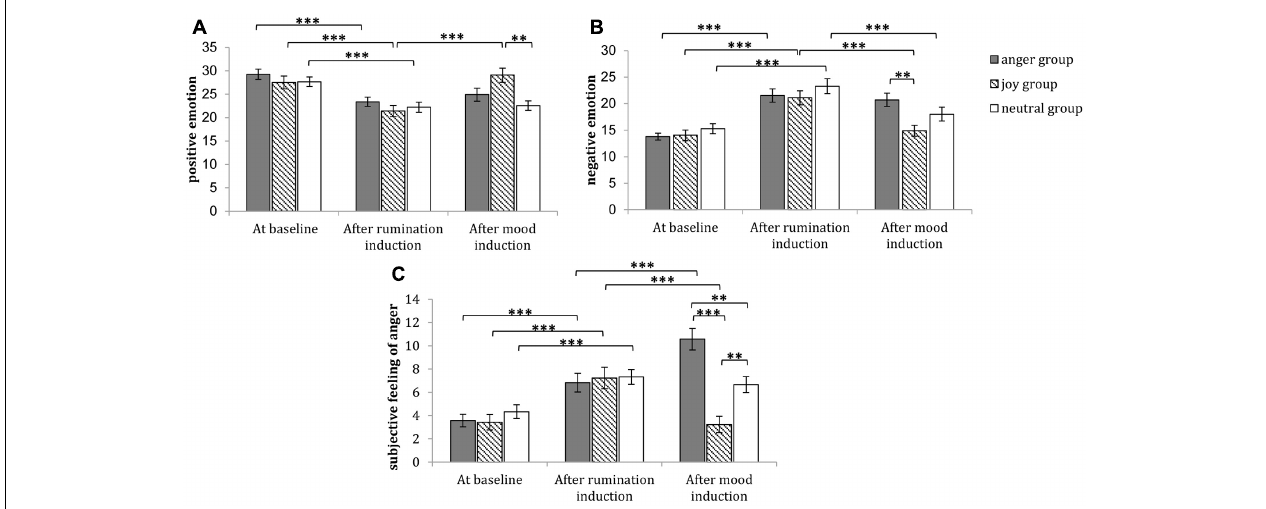
FIGURE 3 | The emotional examination of experimental manipulation in Study 1. The subjective feelings of positive emotion at baseline, after rumination induction and after mood induction are shown in (A) . The subjective feelings of negative emotion at baseline, after rumination induction and after mood induction are shown in (B) . The subjective feelings of anger at baseline, after rumination induction and after mood induction are shown in (C) . And after mood induction, the positive level of joy group was marginally higher than that of anger group ( p = 0.0084). Error bars (capped vertical bars) represent (–1)/(+1) SE . ∗∗∗ p < 0.001, ∗∗ p <